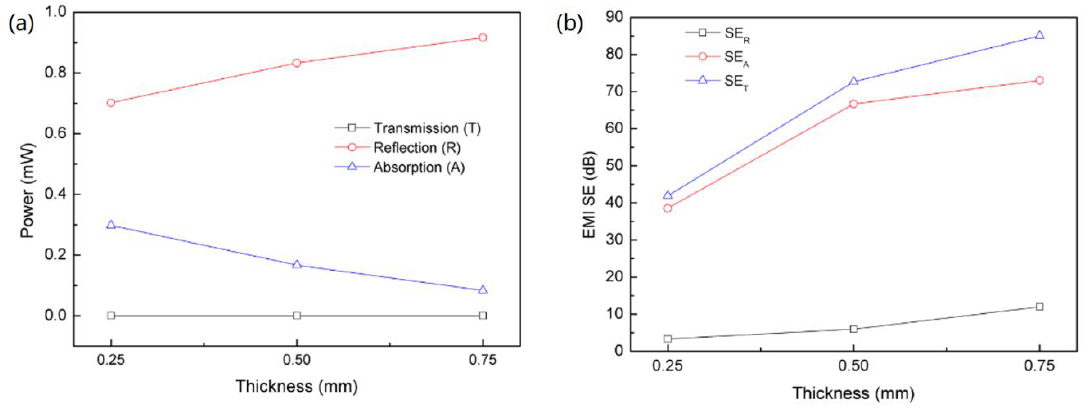
Figure 8. ( a ) Power balance of composites as function of thickness; ( b ) contribution of reflection and absorption to the EMI SE of composites as a function of thickness.